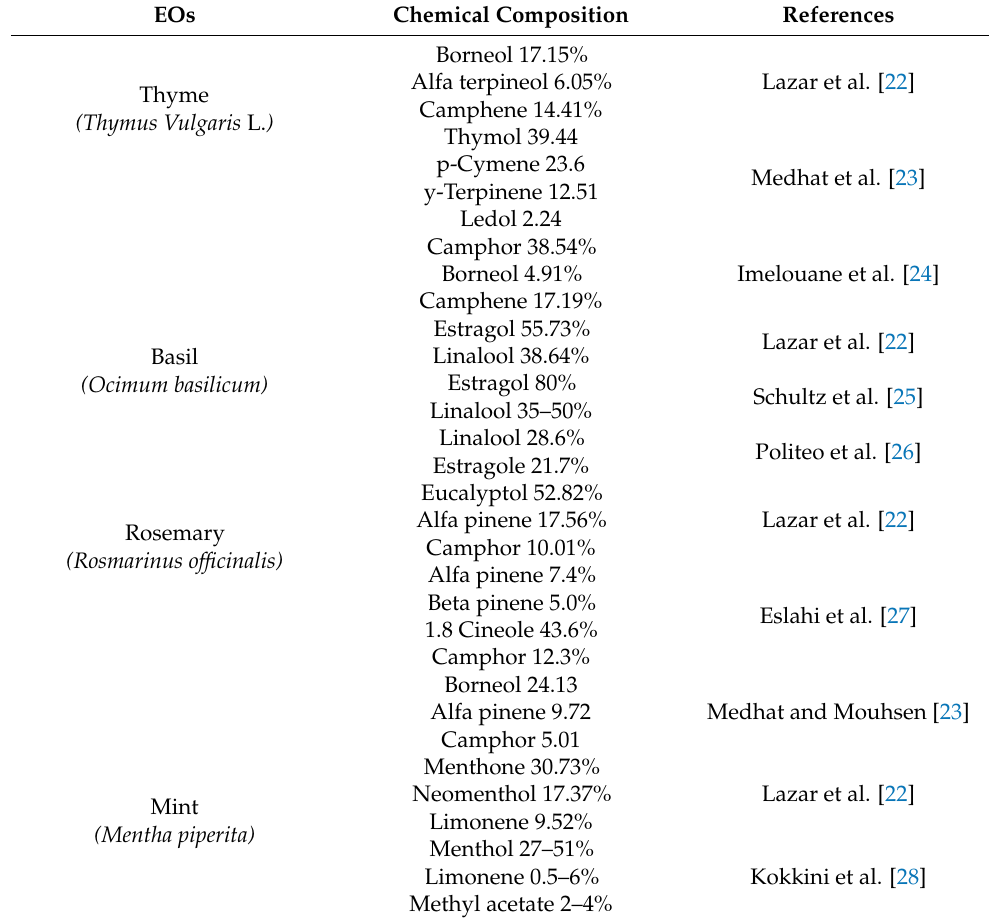
Table 1. Chemical composition of the analyzed EOs. EOs Chemical